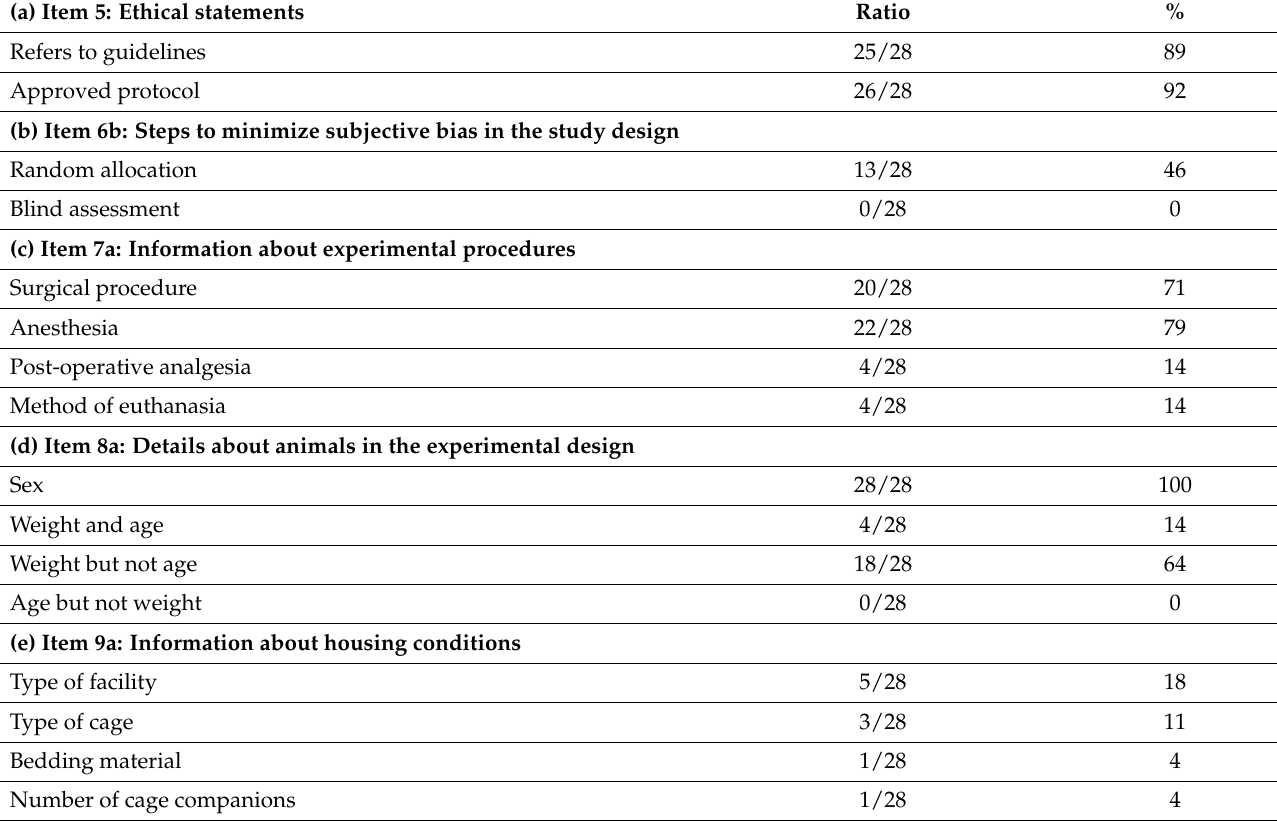
Table 1. Analysis of adherence of the studies to selected items in the